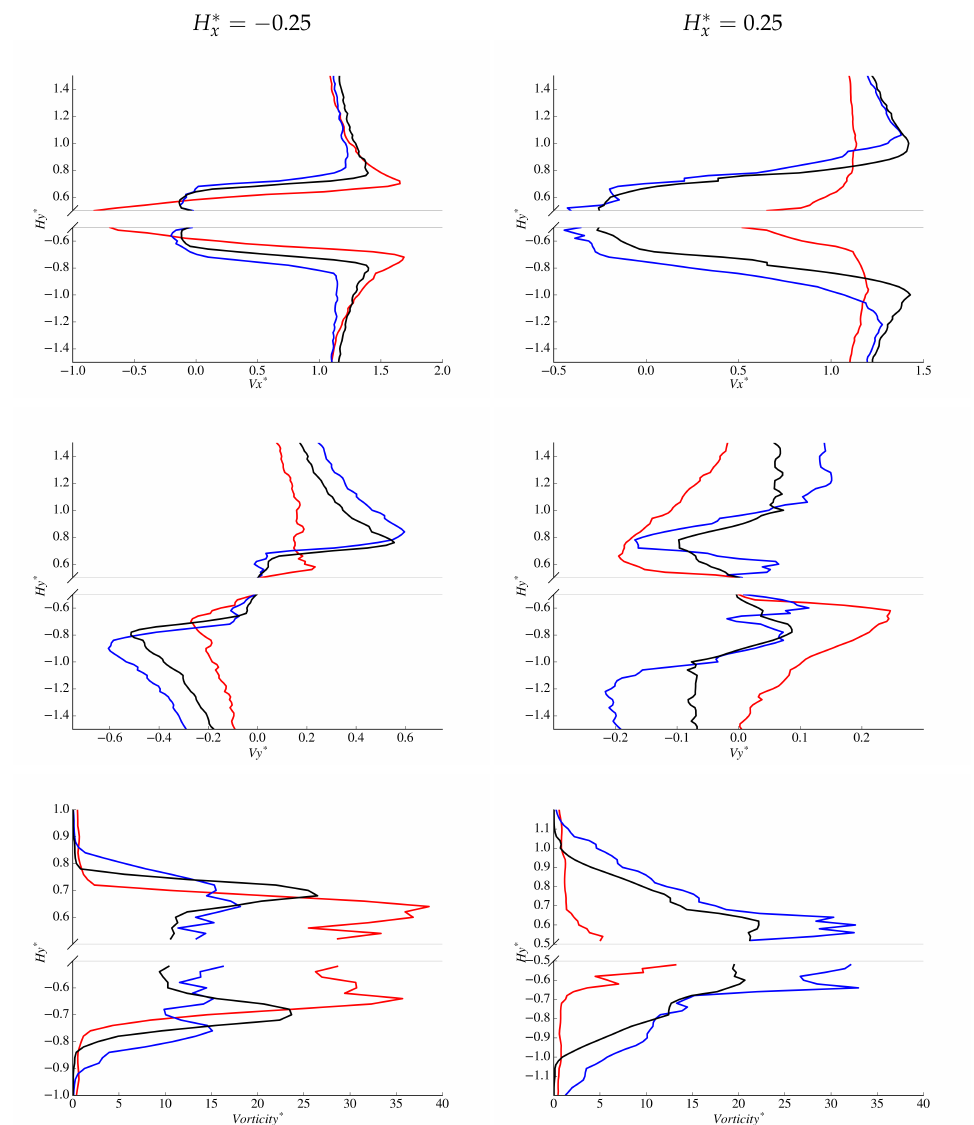
Figure 14. Wall-normal variations of: ( Top ) non-dimensional streamwise velocity, V ∗ x ; ( Middle ) non-dimensional cross-stream velocity V ∗ y ; and ( Bottom ) non-dimensional vorticity magnitude | ω | ∗ at probe locations: H ∗ x = − 0.25 ( left ); and H ∗ x = 0.25 ( right ). The red, blue and black lines represent 0 < a x , a x < 0 and a x = 0 cases,